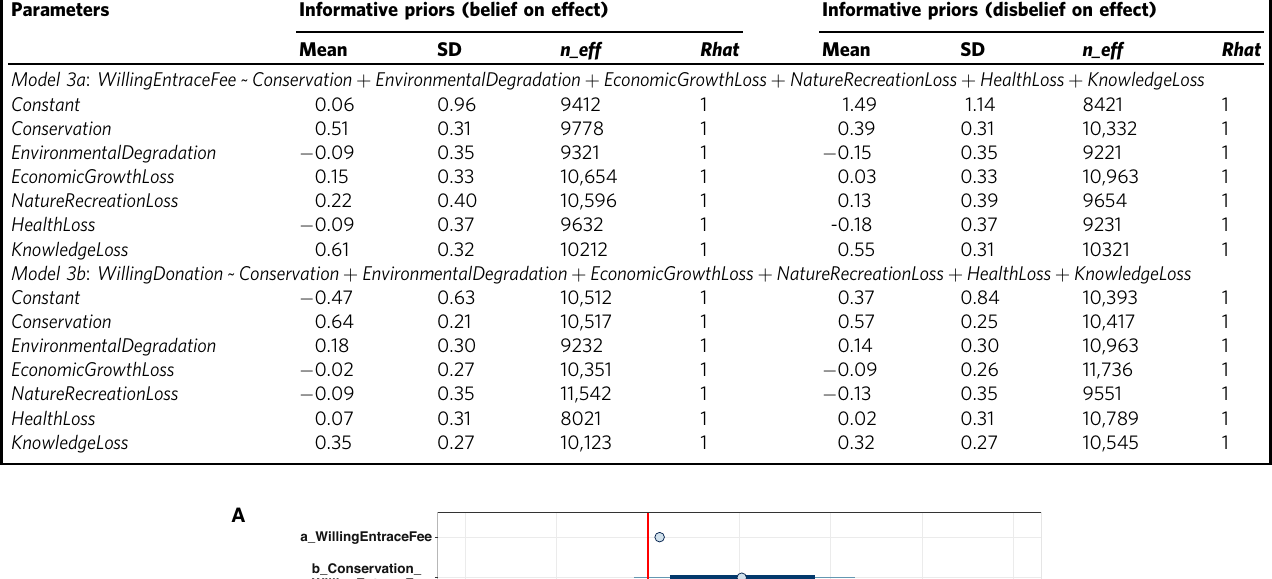
Table 4 Model 3a ’ s and Model 3b ’ s simulated posterior results. Parameters Informative priors (belief on effect) Informative priors (disbelief on effect)